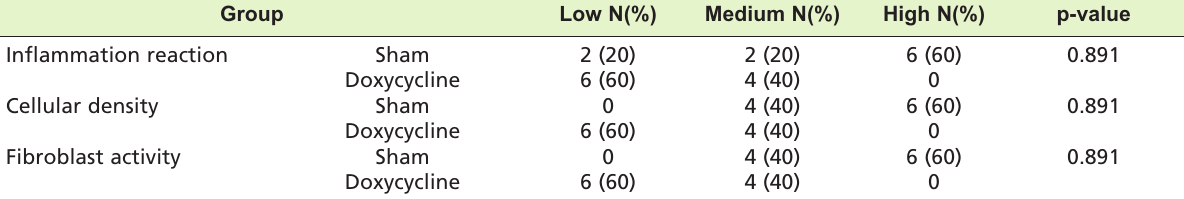
Inflammation reaction, cellular density and fibroblast activity in Sham and Doxycycline groups. Table II: